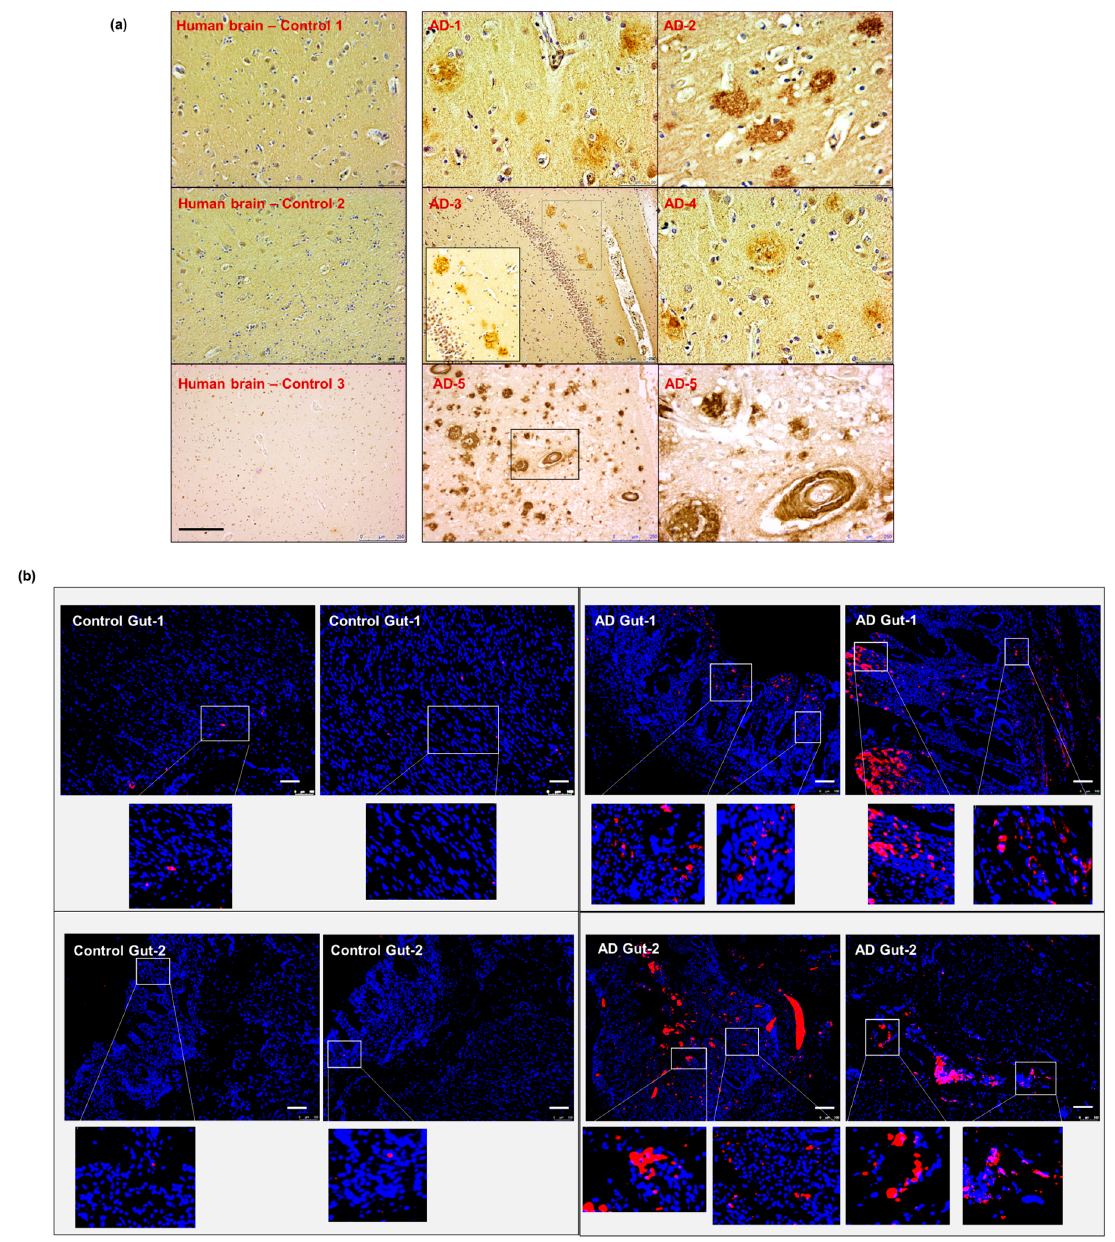
Figure 7. A β detection in human sporadic AD gut and brain samples. ( a ) All five AD human brain samples show significant levels of parenchymal and perivascular A β depositions. ( b ) The gut tissues obtained from two of the same set of AD patients (corresponding to brain samples AD ‐ 1 and AD ‐ 2 in panel ( a ) show the presence of A β‐ aggregation on the epithelium and in the intestinal mucosa. Scale indicates 250 μ m ( a ) and 100 μ m ( b ). Magnification 20× ( a ). AD—Alzheimer Disease brain. Brown—amyloid β aggregates. ( b ) AD—Alzheimer Disease gut. Magnification 20× ( b ). Red—amyloid β , Blue—DAPI nuclei.